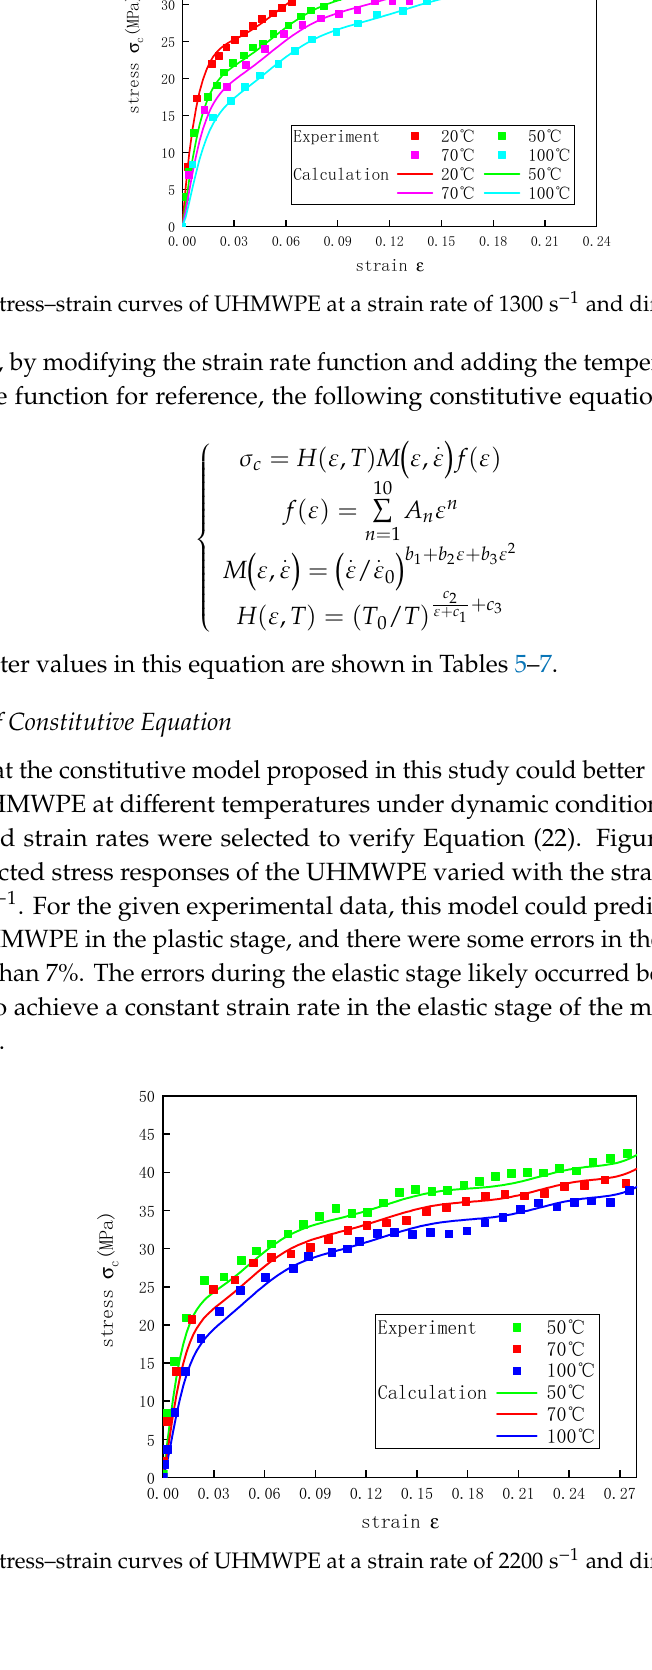
Figure 14. Stress–strain curves of UHMWPE at a strain rate of 3300 s − 1 and different temperatures.